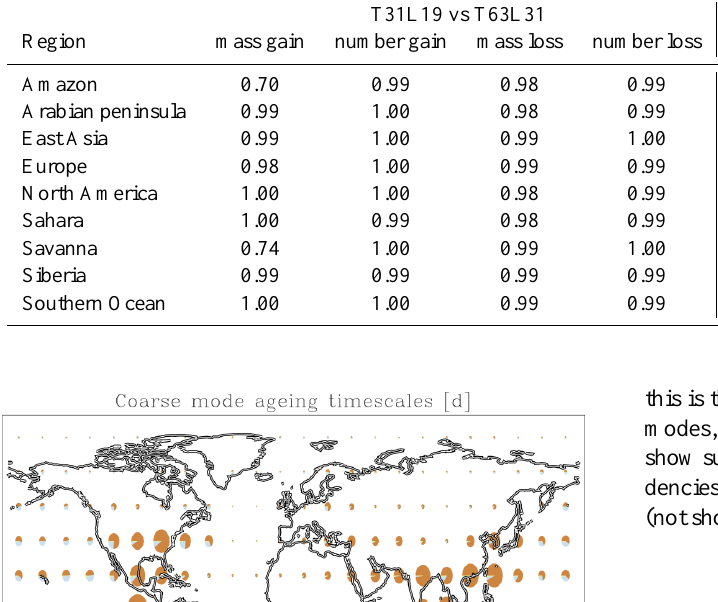
Table 4. Spearman rank correlation of fractional tendencies for different regions and sensitivity experiments T31L19 vs T63L31 PI vs PD emissions